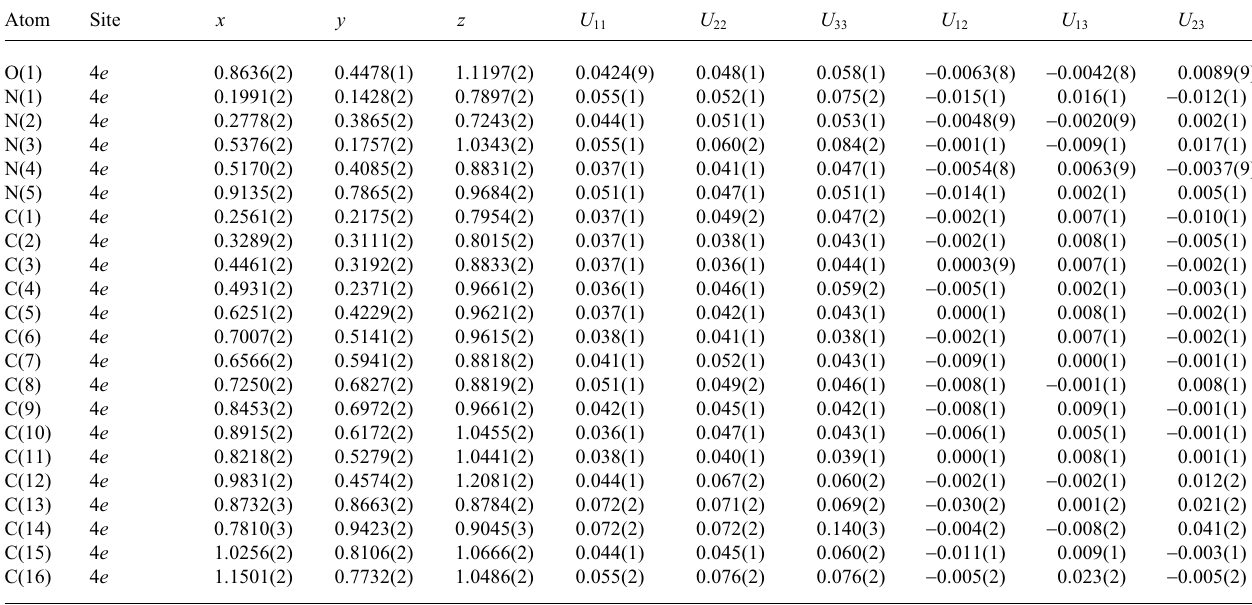
Table 3. Atomic coordinates and displacement parameters (in Å 2